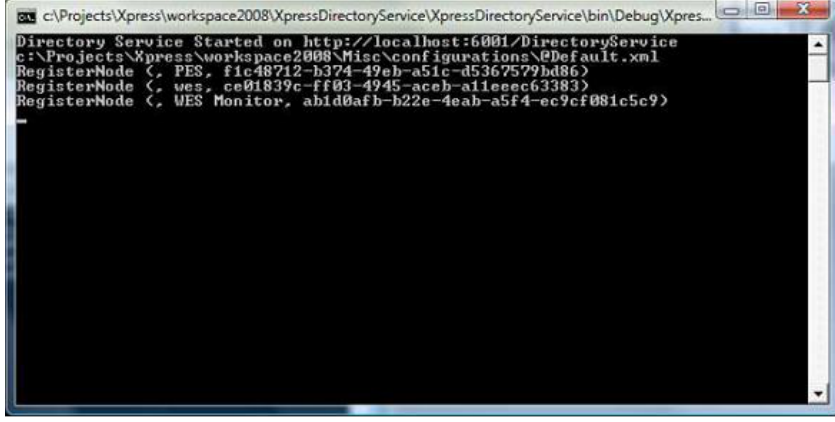
Figure 4. Directory Service